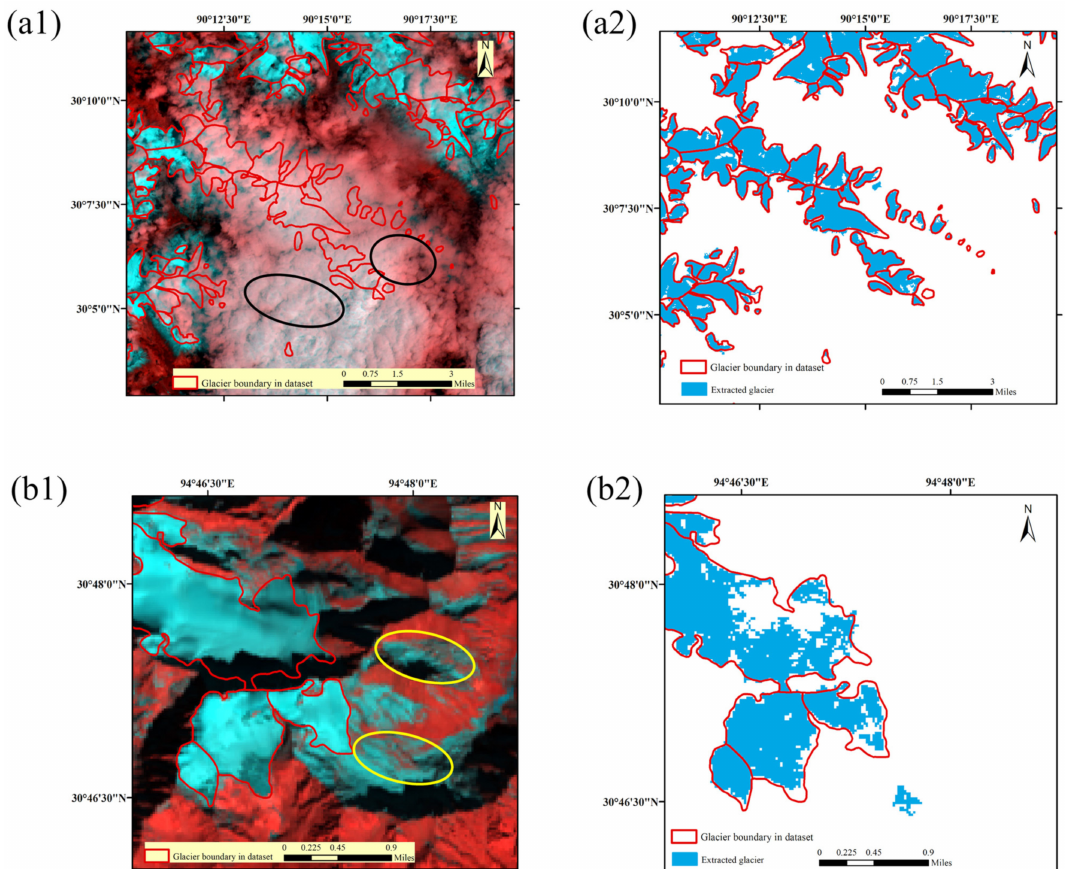
Figure 16. Influences of cloud cover and snow cover. The black and yellow circles refer to clouds and snow,